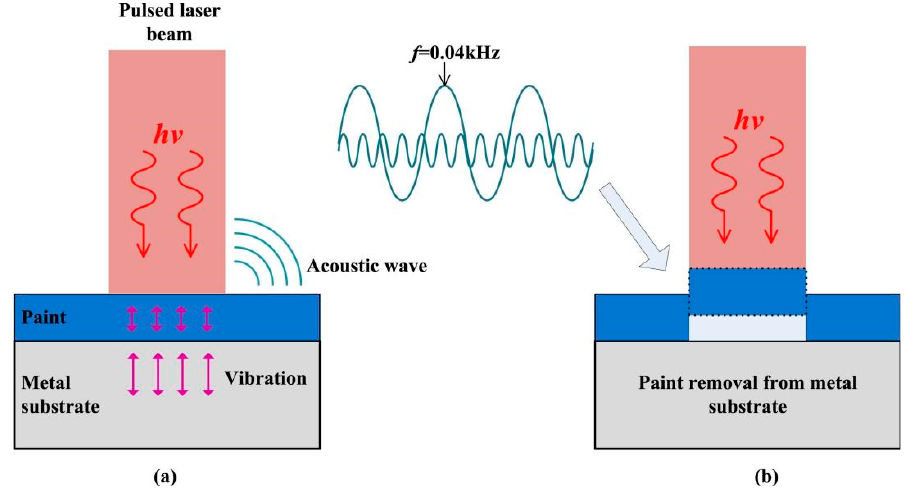
Figure 10. Schematic of the explanation for characteristic frequency. ( a ) The generation of the acoustic wave and ( b ) paint removal from the metal substrate [80].